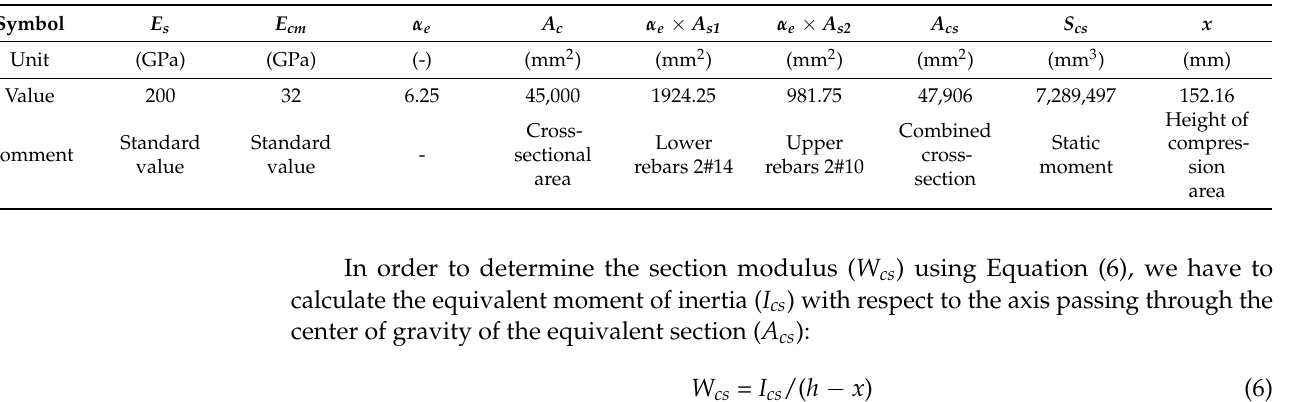
Table 7. The results of calculations required to determine the height of the compression